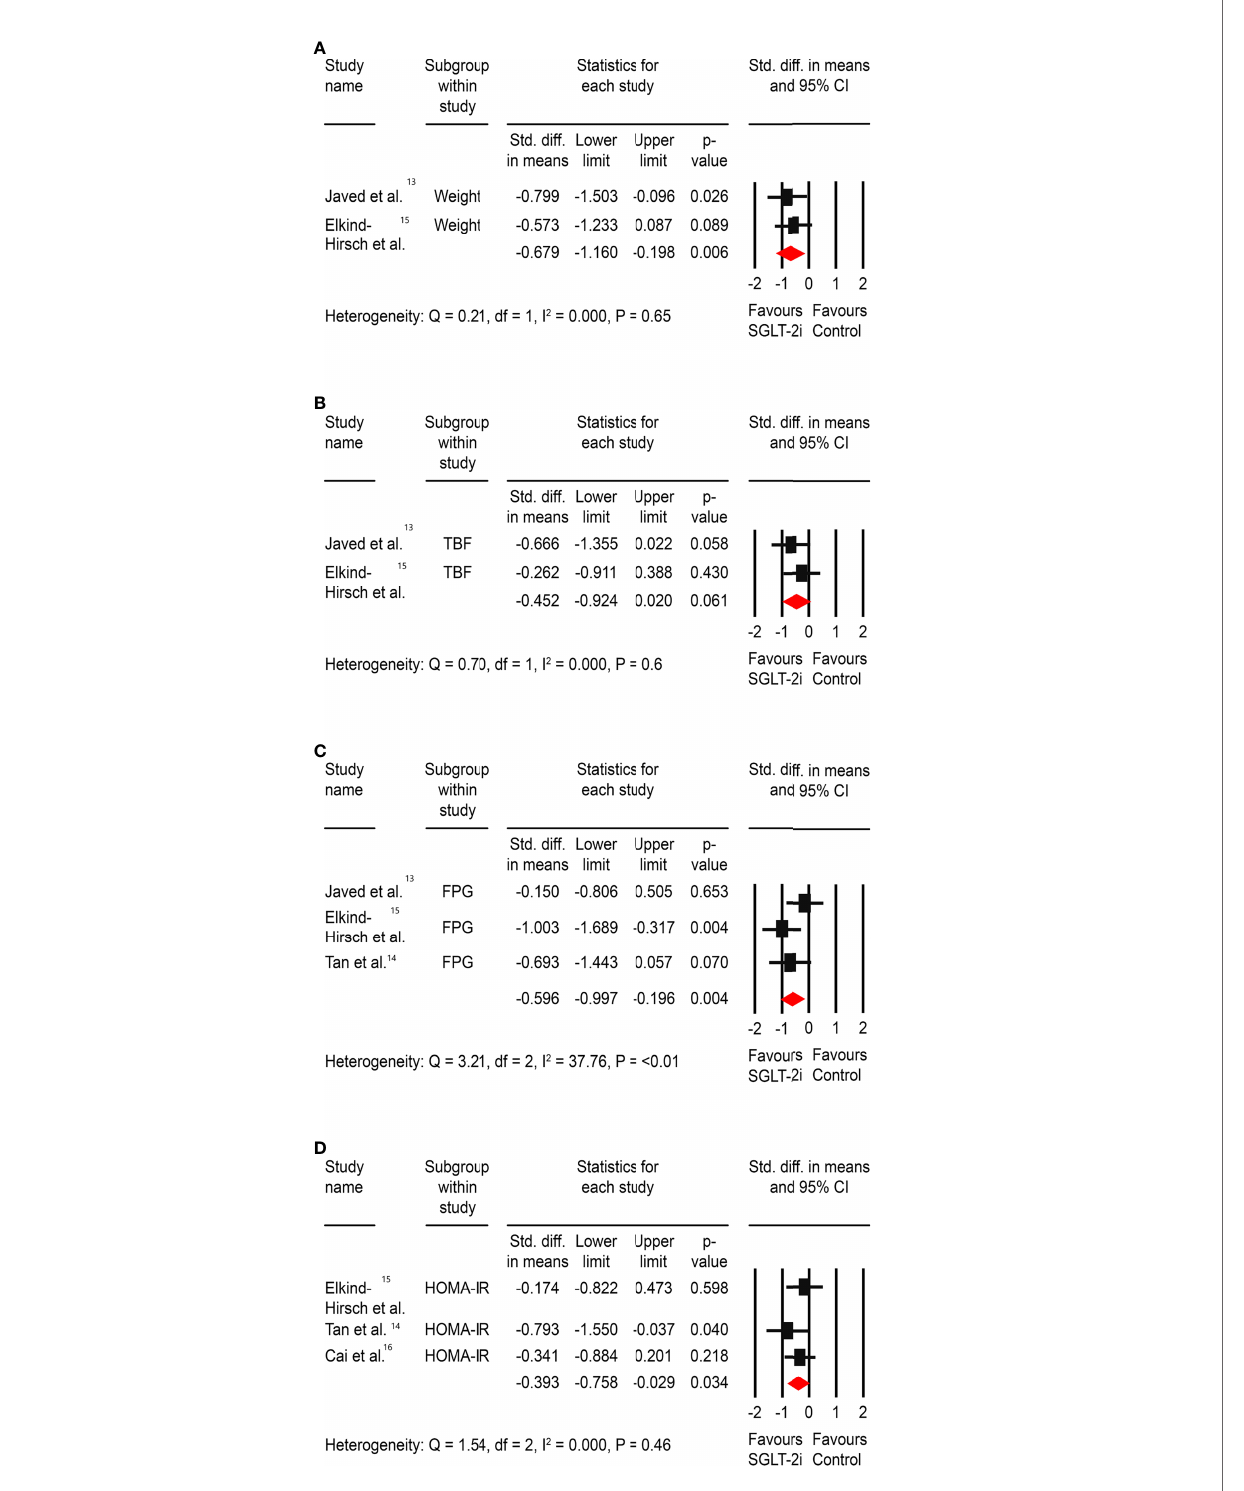
FIGURE 2 | Effect of SGLT-2is versus control on (A) weight, (B) total body fat (TBF) %, (C) fasting plasma glucose (FPG), and (D) insulin resistance – HOMA-IR. *Std: